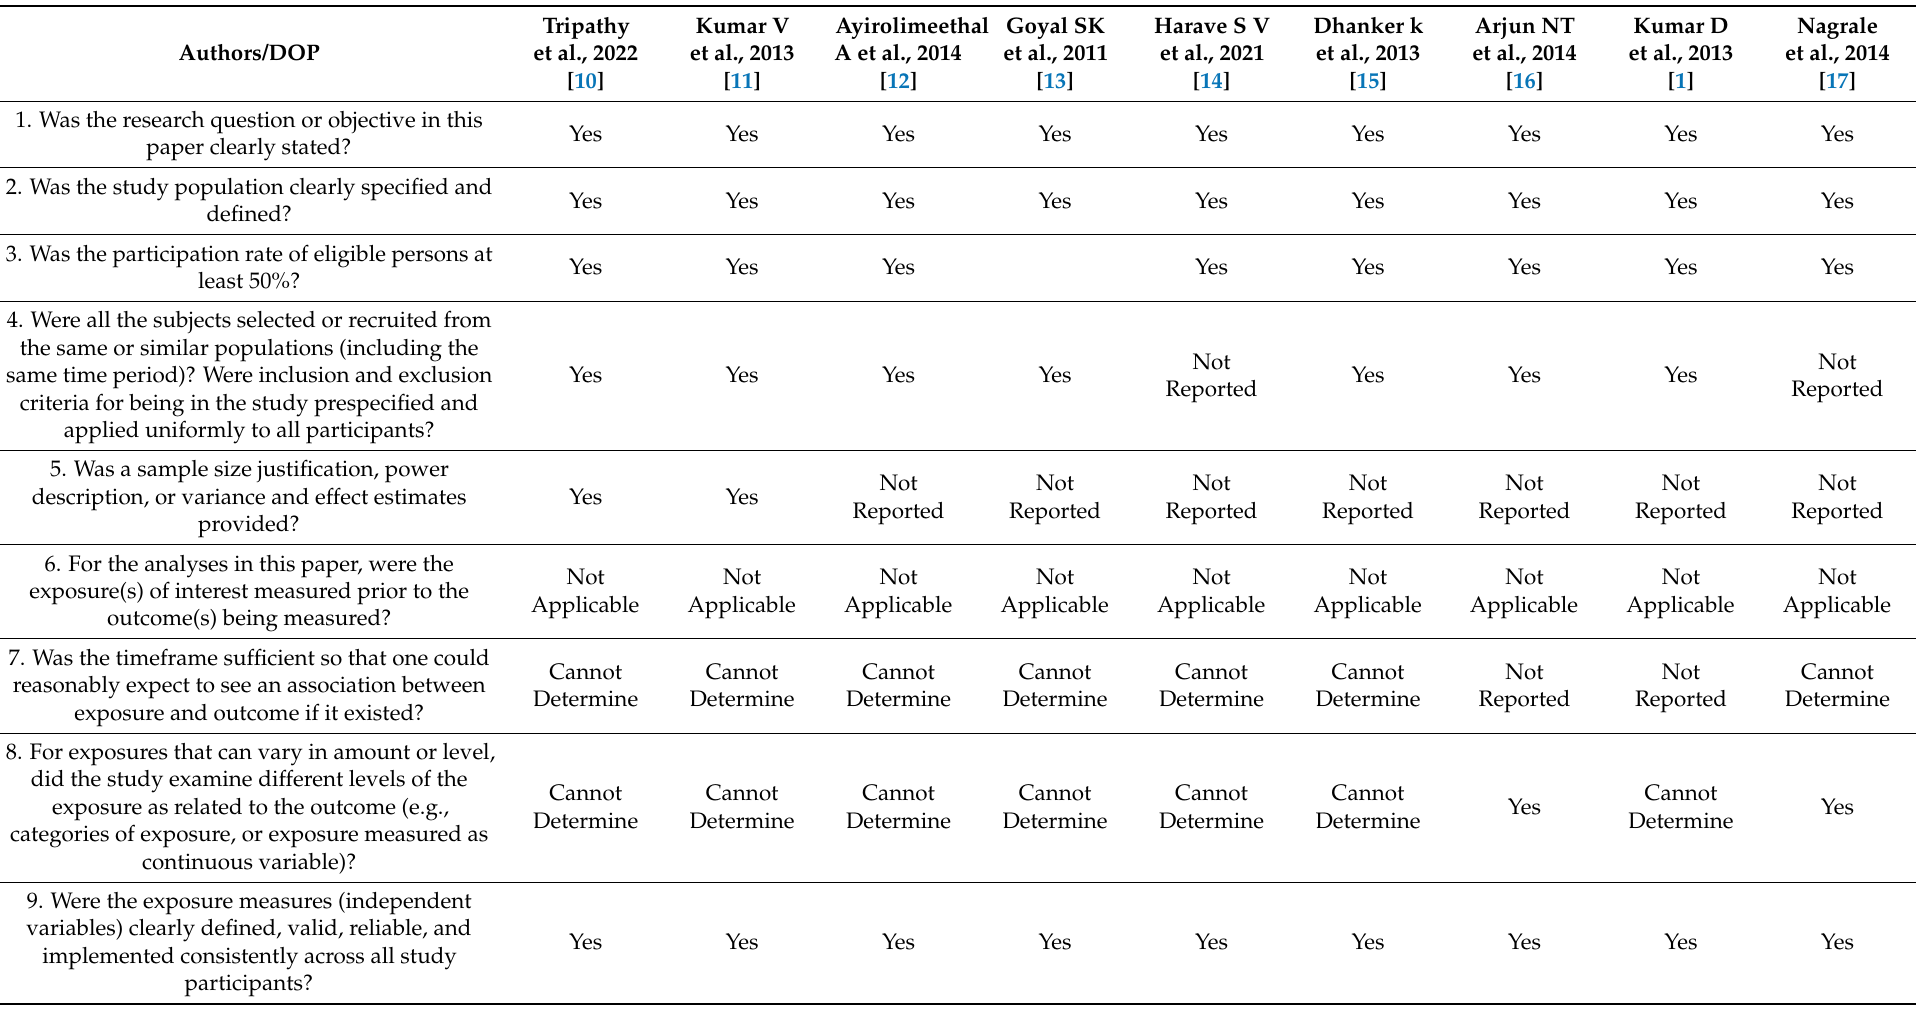
Table A3. Quality assessment of studies examining NCD among Prisons in India (N = 9)